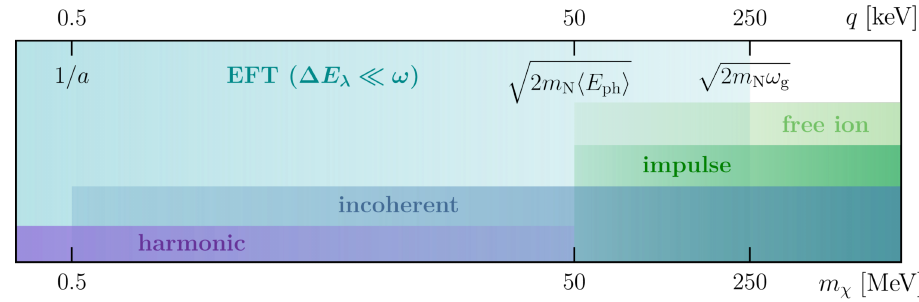
Figure 1. Schematic representation of the regimes of validity of the different approximations discussed in this work. Here m N is the nucleus mass, a the lattice spacing, h E ph i the typical average phonon energy, and ω g the semiconductor gap. Both the impulse and the free-ion approximation are valid when the momentum transfer is much larger than the typical momentum scale set by p the crystal, q (cid:29) 2 m N h E ph i . However, the free-ion approximation is parametrically slower than the impulse approximation at converging to the corresponding approximate value. Corrections p to the free-ion approximations are, in fact, proportional to h E ph i /E r , while corrections to the impulse approximation are proportional to h E ph i /E r (see section 4.1.2 for details). The harmonic p approximation is, instead, valid in the opposite regime, q (cid:28) 2 m N h E ph i , where corrections to the atomic potential that are higher than quadratic in the positions are neglected, and the displacement of the nucleus by the DM scatter is small compared to the inter-atomic spacing. The incoherent approximation applies to processes where the momentum exchanged is, instead, much larger than the inverse lattice spacing, q (cid:29) 1 /a , when the scattering particle is able to discriminate each single nucleus and hence does not scatter coherently off multiple lattice sites. Finally, the EFT presented in this work is valid when the separation between the lattice energy levels excited by the DM, ∆ E λ , is much smaller than the energy of the Migdal electron, ω — i.e., for momentum transfers q (cid:28) p 2 m N ω g . Note that close to the boundaries of the indicated regions of validity, the approximations will receive O (1) corrections. The numerical values are estimated for the case of silicon, for which m N ’ 28 GeV, ω g ’ 1 . 2 eV, and h E ph i ’ 0 . 04 eV. The typical DM velocity is taken to be v χ ’ 10 − 3